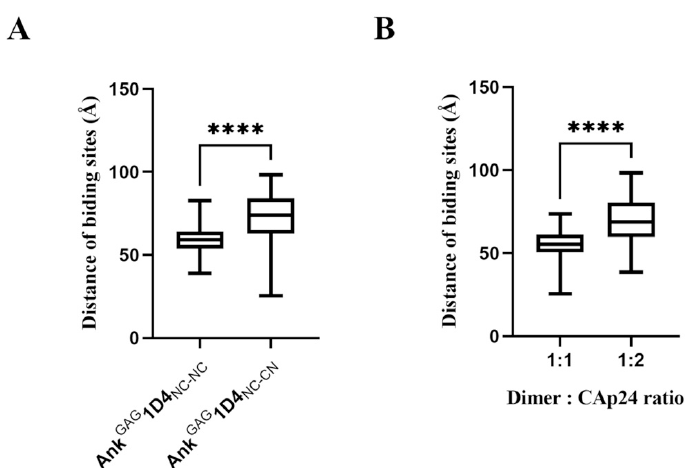
Figure 2. Distance of binding sites of Ank GAG 1D4 NC-NC and Ank GAG 1D4 NC-CN : ( A ) The binding sites distance of Ank GAG 1D4 NC-NC with 59.3 ± 7.5 Å ( n = 397) and Ank GAG 1D4 NC-CN with 71.9 ± 15.0 Å ( n = 403); ( B ) The binding sites distance of Ank GAG 1D4 NC-NC and Ank GAG 1D4 NC-CN show 1:1 interaction at 54.8 ± 9.1 Å ( n = 217) and 1:2 interaction at 69.7 ± 12.6 Å ( n = 583). This data denote mean ± SD. **** p < 0.0001 using two-tailed unpaired t -test.